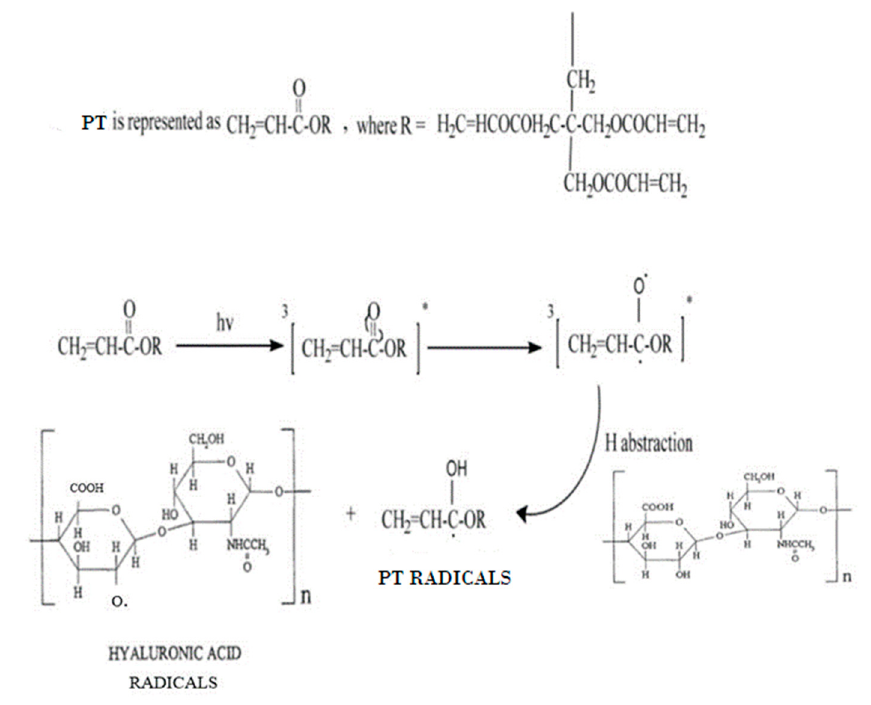
Figure 3. Generation of reactive HA free radicals with the aid of PT as photo-initiator [10].